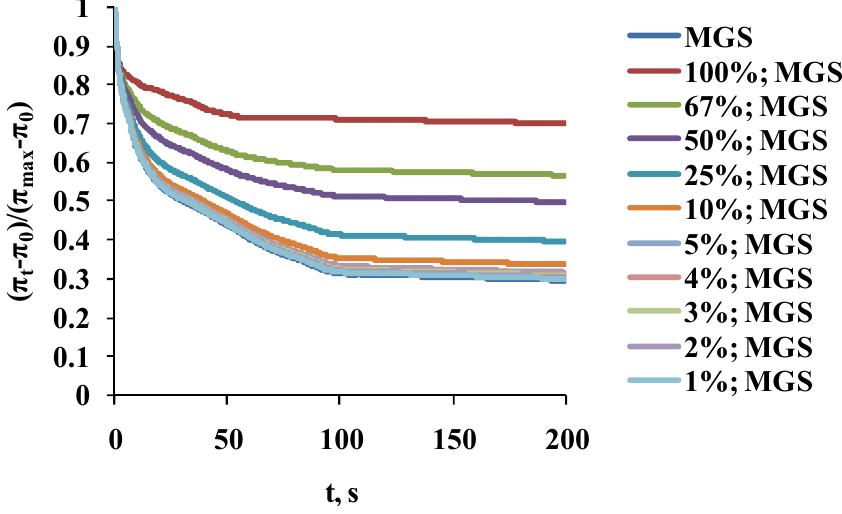
Figure 4. Surface pressure stress-relaxation transients of MGS films, intact and with different degree of catalytic saturation.